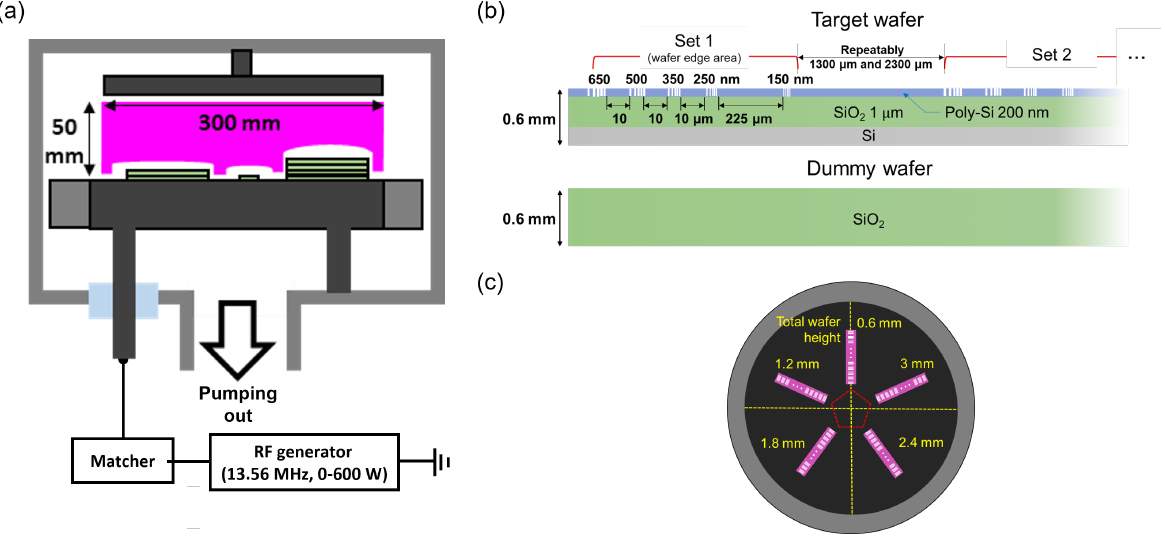
Figure 1. ( a ) A schematic of the experiment setup, ( b ) schematic showing the properties of a wafer, and ( c ) the top view of the powered